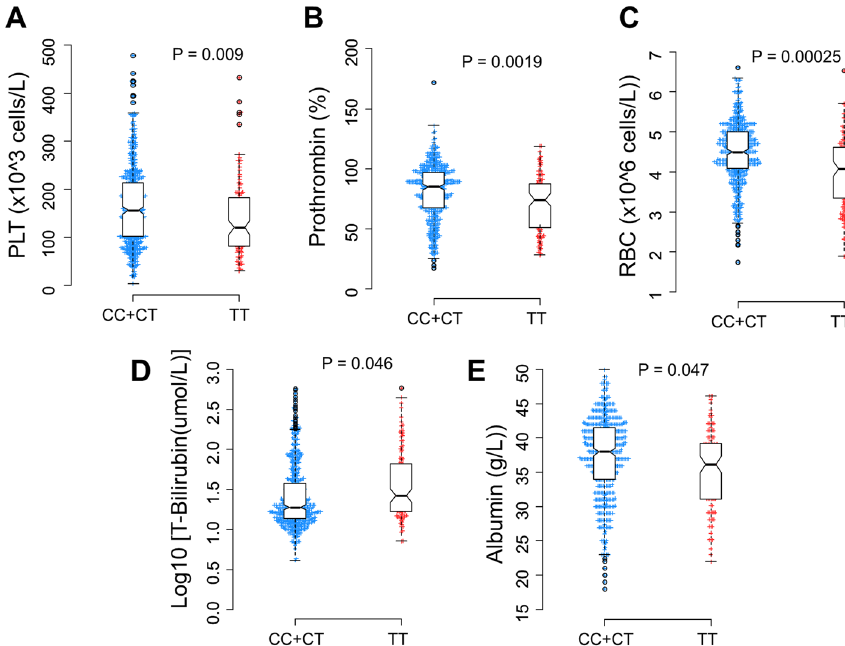
Figure 3. Association of PD-1.9 variant with distinct laboratory parameters in HBV patients. Box-plots illustrate median values with 25 and 75 percentiles with whiskers to 10 and 90 percentiles; p- values were calculated by Mann–Whitney